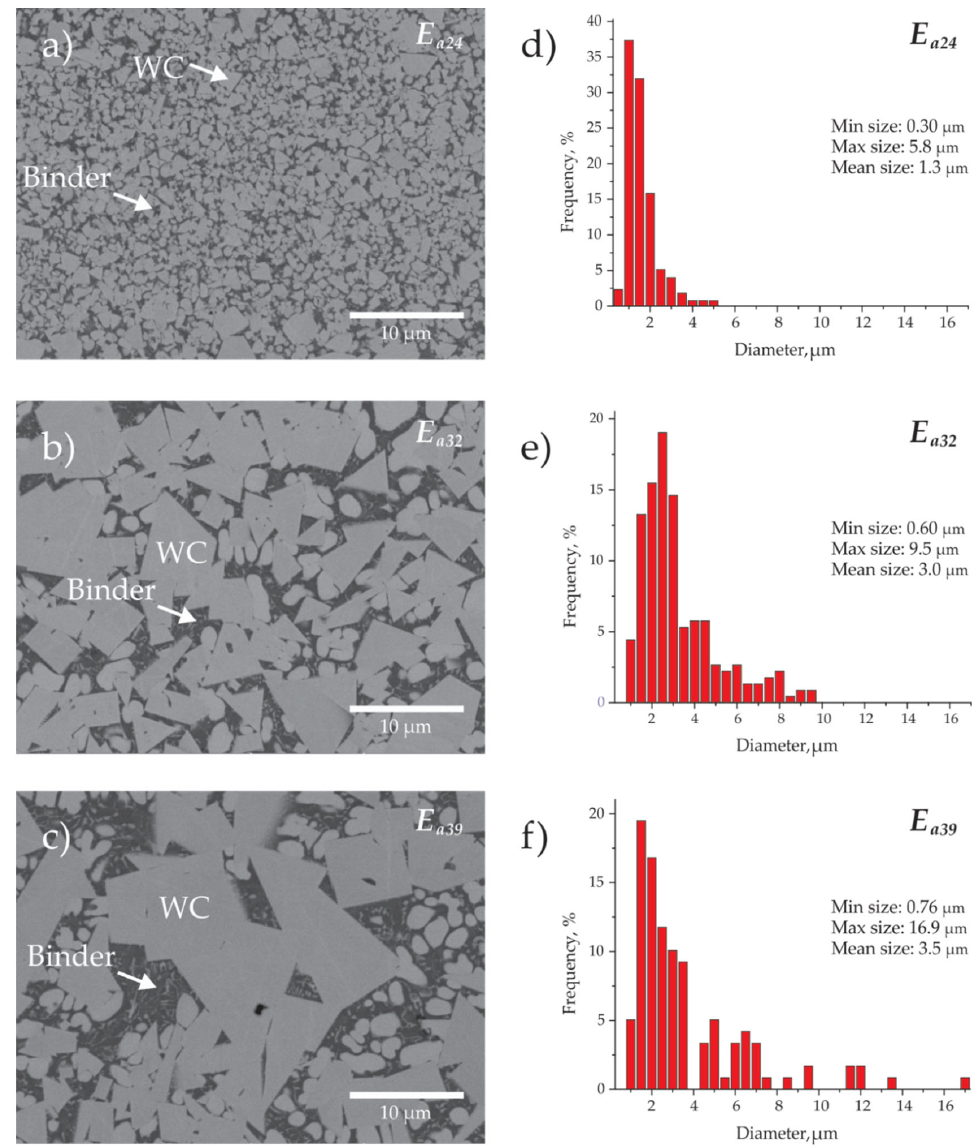
Figure 8. Microstructure at the inner region for E a conditions ( a ) E a24 , ( b ) E a32 and ( c ) E a39 . Distribution frequency WC particle size ( d ) E a24 , ( e ) E a32 and ( f ) E a39 .